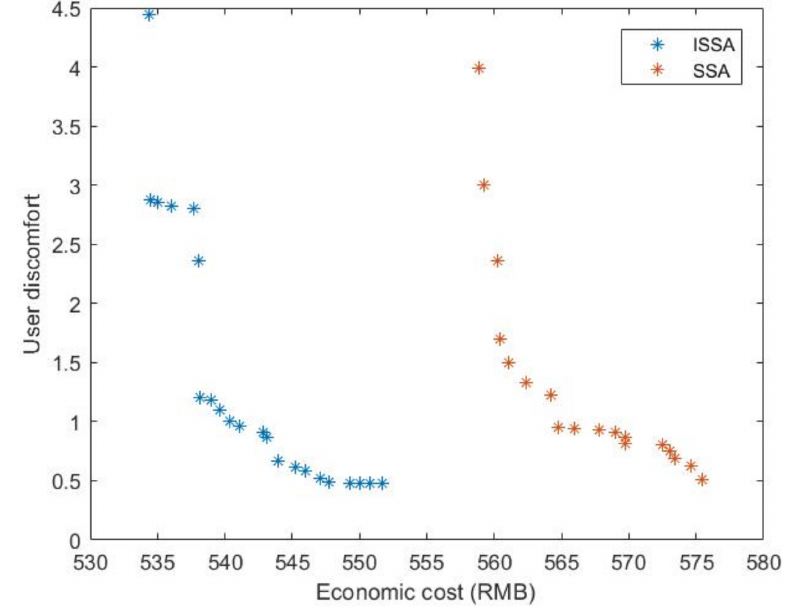
Figure 12. Pareto optimal solution set of multi-objective